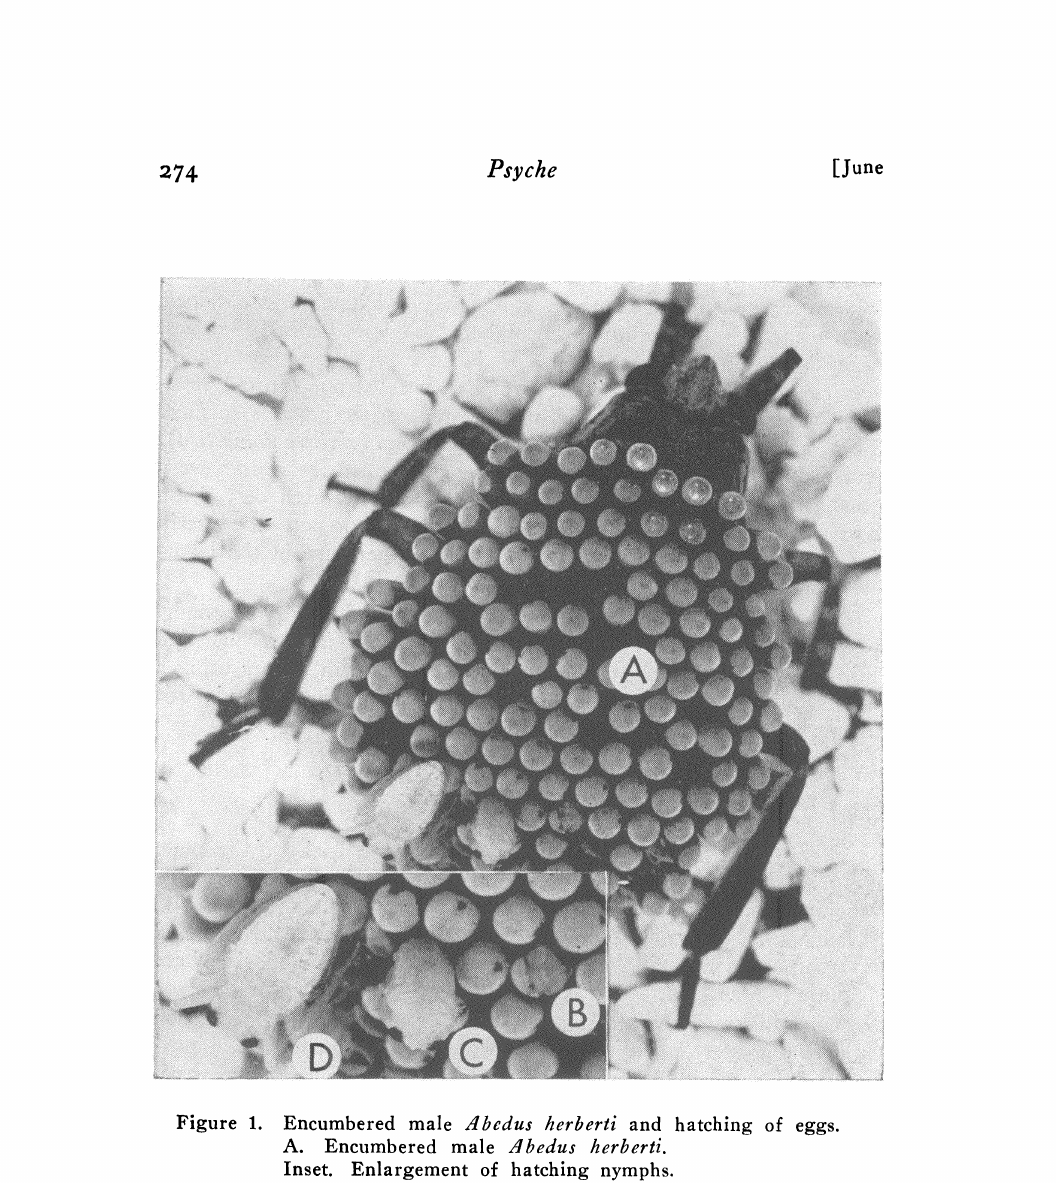
Figure 1. Encumbered male lbedus herberti and hatching of eggs. A. Encumbered male lbedus herberti. Inset. Enlargement of hatching nymphs. B. Rupture of the chorion around cap. C. Resting position. D. Newly emerged